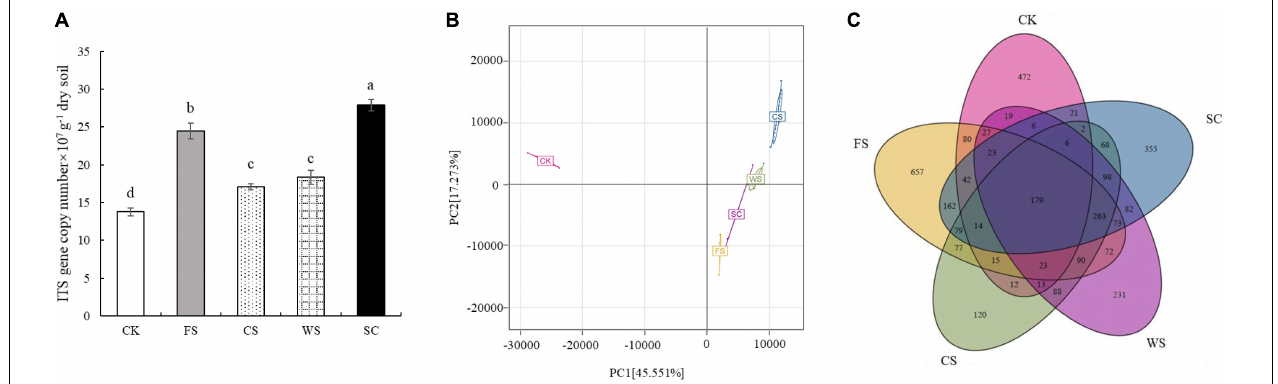
FIGURE 1 | Differences in soil fungal community structure in different cropping systems. (A) The abundance of fungal ITS rRNA gene copies assessed by real-time PCR in five soybean cropping systems. Different letters represent significant differences ( P < 0.05), (B) principal coordinate analysis (PCA) plot based on the OTUs for five soybean cropping systems. (C) Venn diagram of OTU distribution comparison. The numbers represent the number of species. SC, soybean continuous cropping; CK, fallow; FS, fallow-soybean; CS, corn–soybean; WS, wheat–soybean.